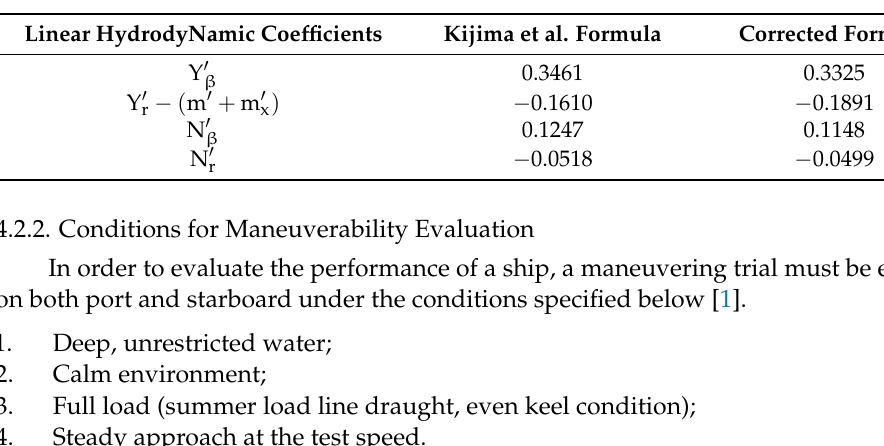
Table 5. Main specifications of Target fishing vessel.